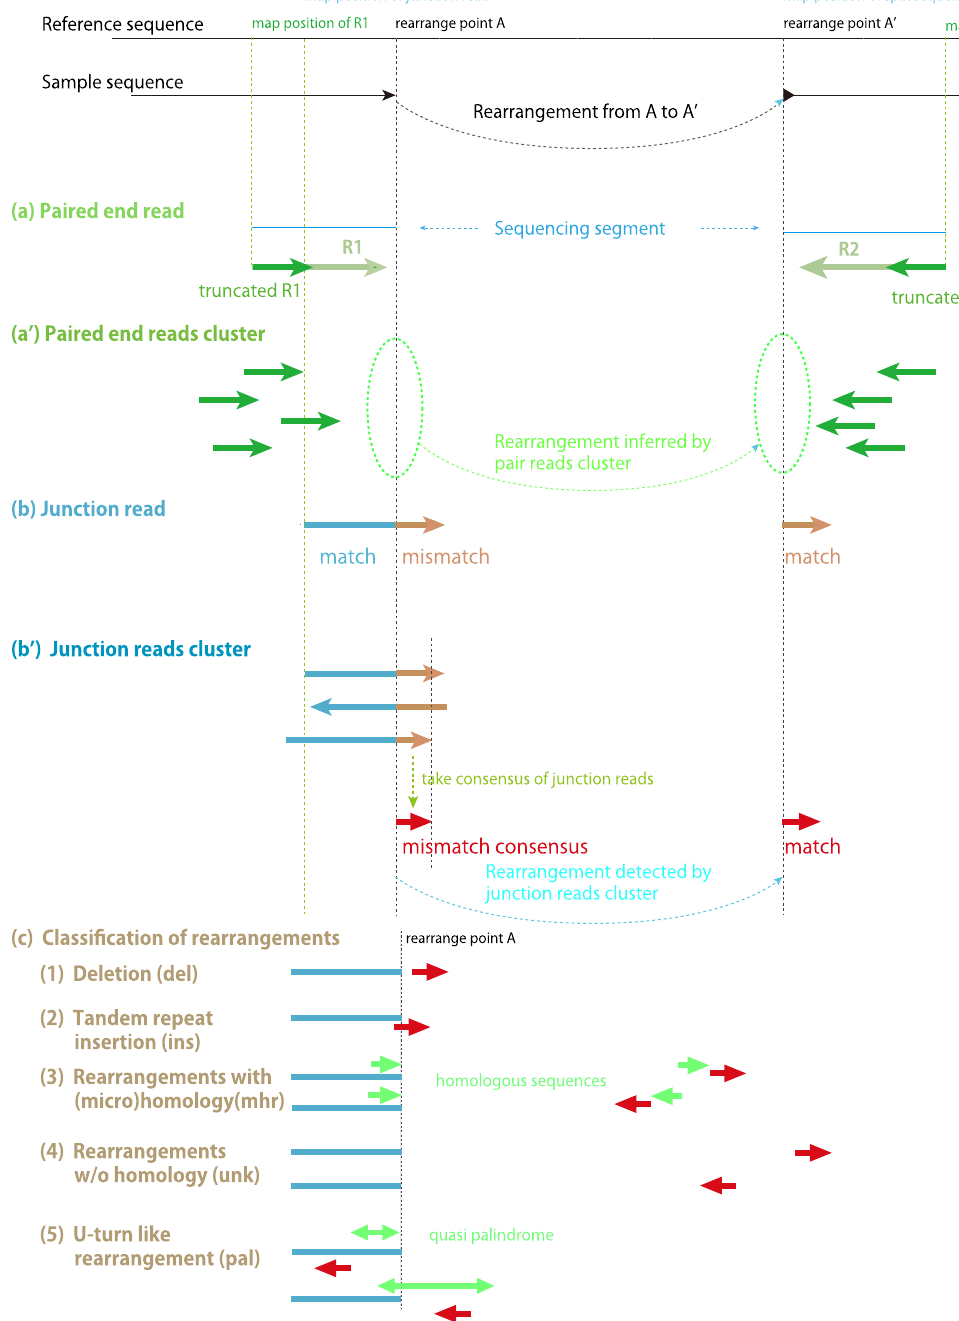
Fig. 3 Detection of rearrangement by (a) paired-end reads and (b) junction reads. A rearrangement within a sequencing segment can be detected when the distance between the mapped positions of paired-end reads, R1 and R2, is longer than expected or pointing toward the same direction ( a ). Paired reads sharing locations in close vicinity are collected to determine the presence and position of rearrangement ( a ′ ). The rearrangement can be detected as a junction read when one side of the read matches one position in the genome, and the other side matches a different position ( b ). Junction reads sharing the same boundary are collected as a junction cluster, and the consensus of mismatch sequence is searched on genome to locate the rearrange position ( b ’ ). Based on the relative positions and sequences around them, rearrangements are classi fi ed into fi ve categories ( c ). (1) Deletion (del), (2) Tandem repeat insertion (ins), (3) Rearrangements caused by microhomology (mhr), (4) Rearrangements without sequence similarity (unk), and (5) U-turn like rearrangement sequence, or not mapped on appropriate position relative to the INDELs shorter than 50 bps are categorized as (1) Deletion (del) positions of the latter end (arrowhead) of the junction read. and (2) Insertion (ins). Note here we only detect tandem repeat for Junction clusters are then categorized into fi ve groups regarding insertions, but insertions of arbitrary sequence. Rearrangement the type of rearrangement (Fig. 3c). They include short INDELs between two distant locations on reference are categorized as (3) because we do not allow gapped alignment while mapping. Rearrangement based on microhomology/homology (mhr) if there